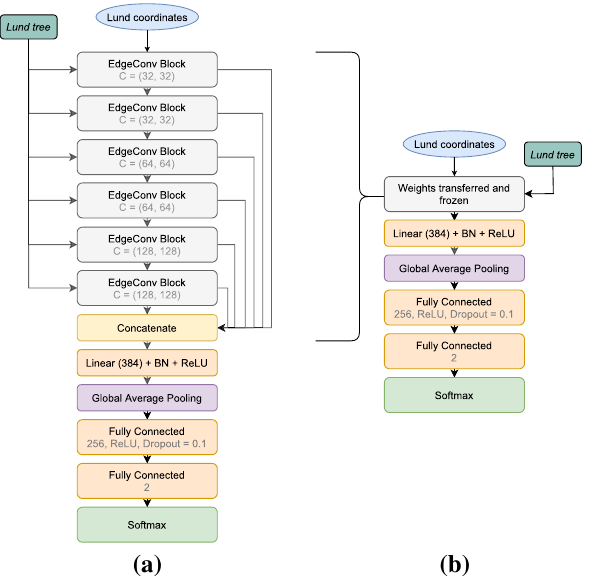
Fig. 2 A flowchart representing the LundNet architecture and the transfer learning procedure employed in this